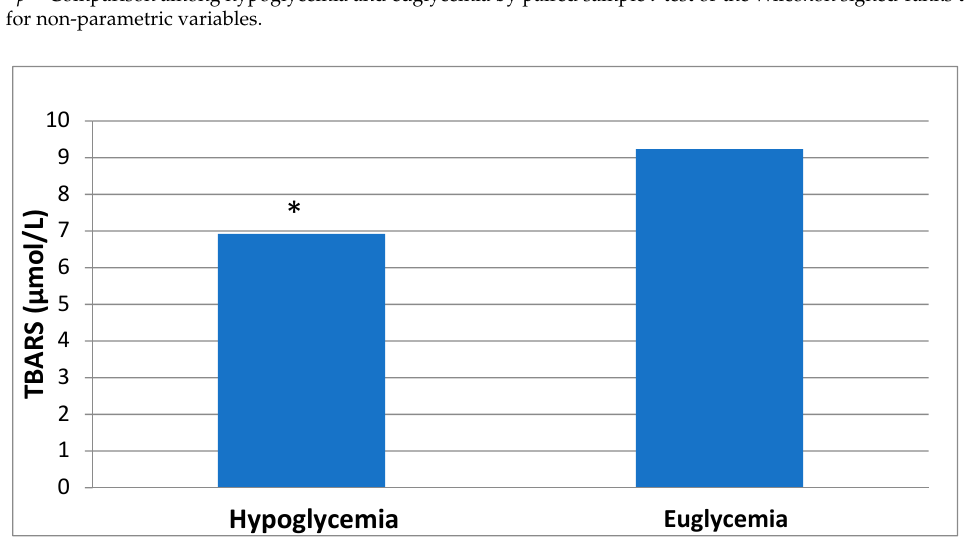
Figure 1. Comparison of TBARS levels between hypoglycemia and euglycemia. * p = 0.005 hypoglycemia vs. euglycemia.